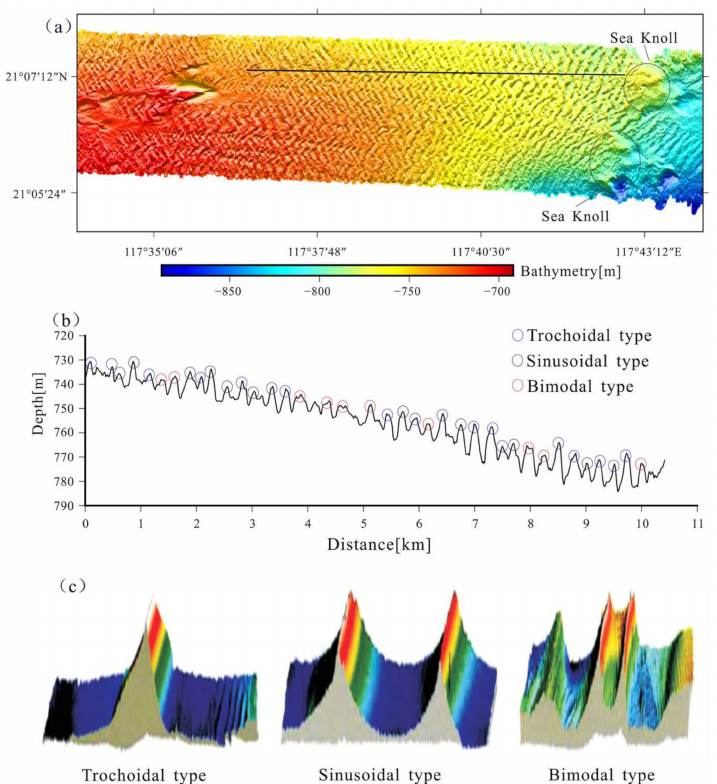
Figure 9. Geometry of the submarine parallel dunes in the Northeast of the Dongsha atoll. ( a ) Multi- beam bathymetry map of the parallel dunes. The detailed location of the parallel dunes is shown in Figure 1c. ( b ) Interpretation and classification of the parallel dunes. The blue circle represents the trochoidal type, the black circle represents the sinusoidal type, and the red circle represents the bimodal type. ( c ) Typical geomorphological classification of the submarine parallel dunes (modified after